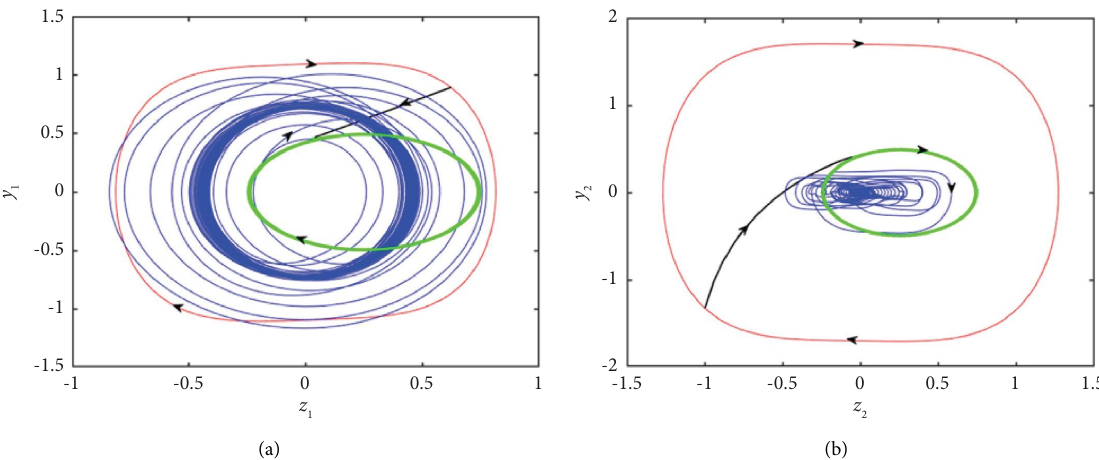
Figure 9: Te phase trajectories of the system responses under the OLPNCL control. (a) Te mechanical equipment response phase trajectory. (b) Te NES response phase trajectory.